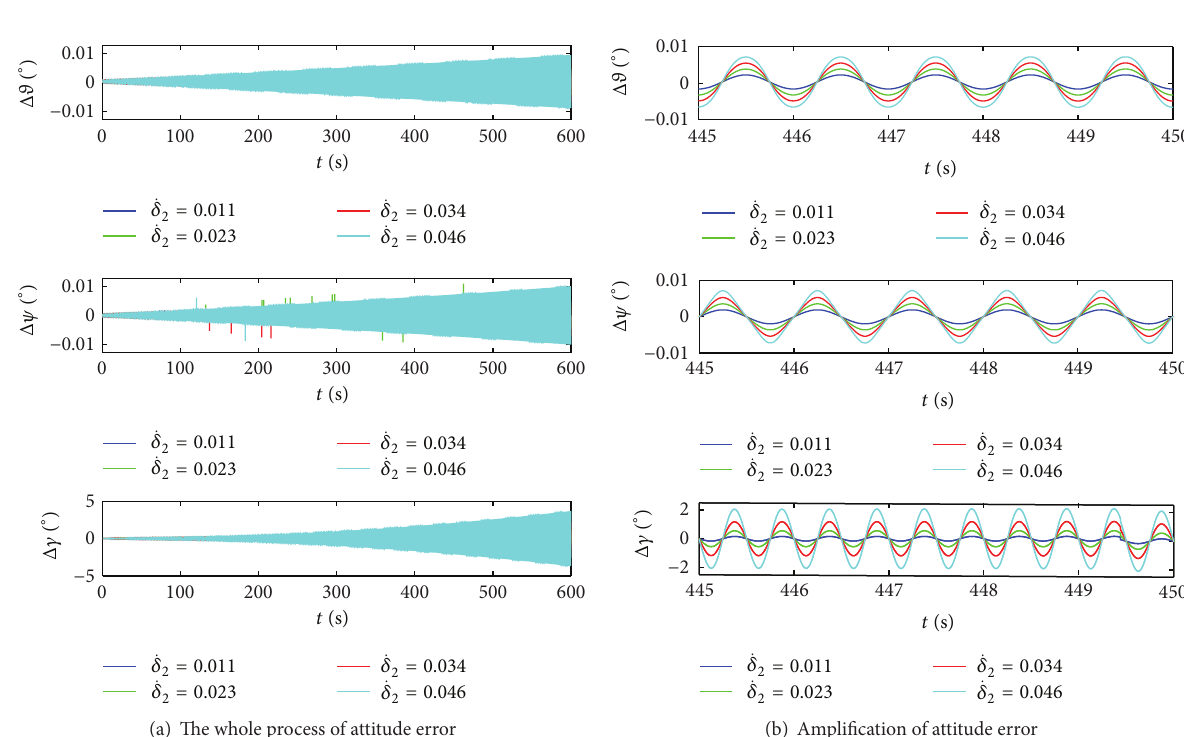
Figure 5: Attitude error by varying Λ